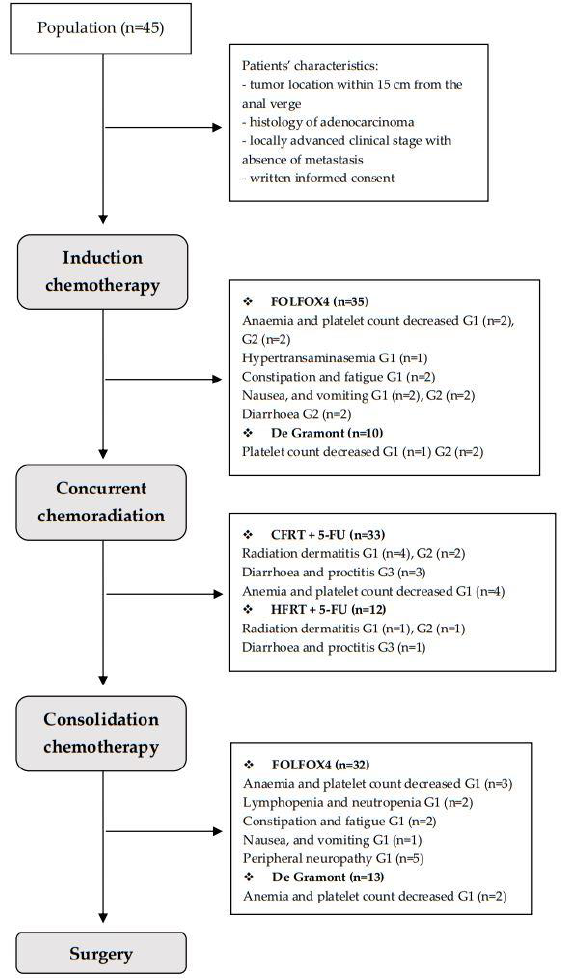
Figure 1. Consort diagram showing the different application and feasibility of preoperative induction chemotherapy (FOLFOX4, De Gramont) radio-chemotherapy (CFRT, HFRT), and consolidation chemotherapy (FOLFOX4, De Gramont).